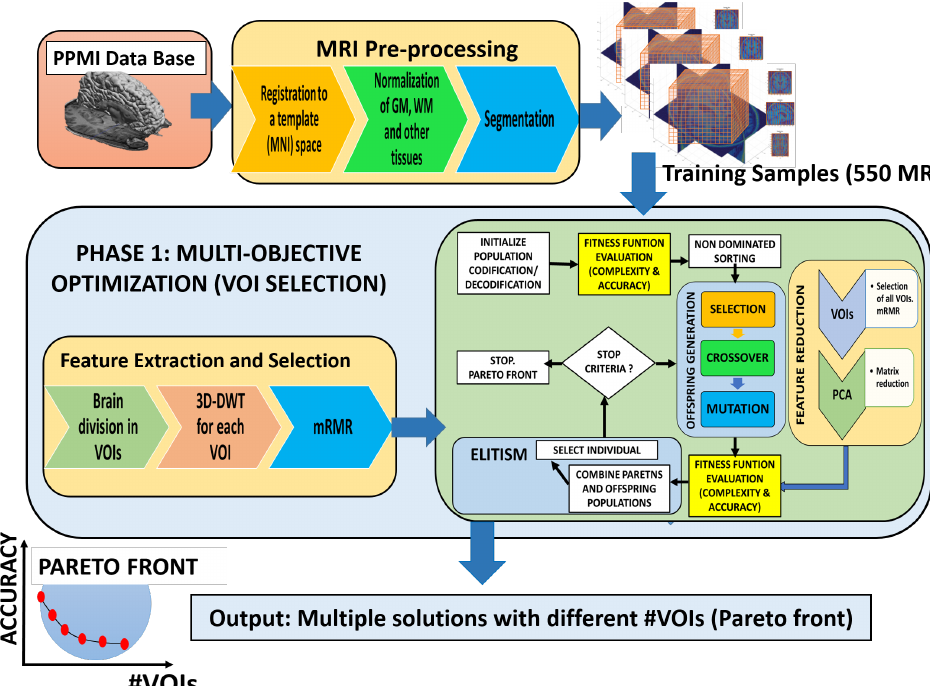
Figure 1. The block scheme for multi-objective optimization. Phase 1: VOI